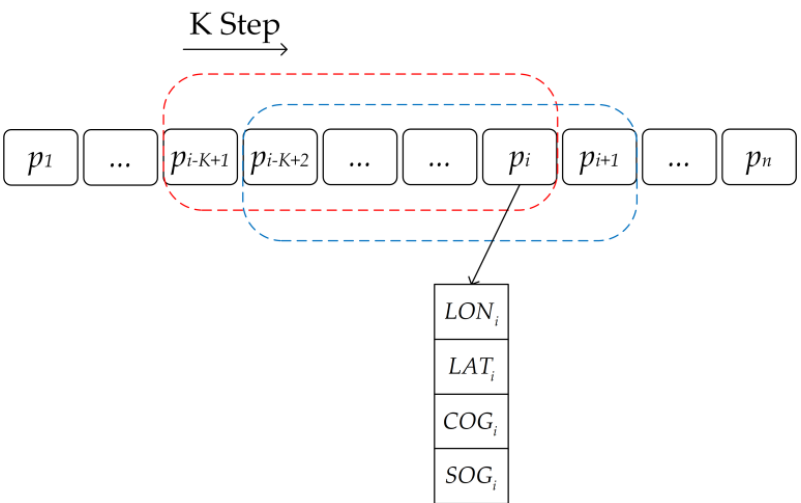
Figure 2. Sliding time